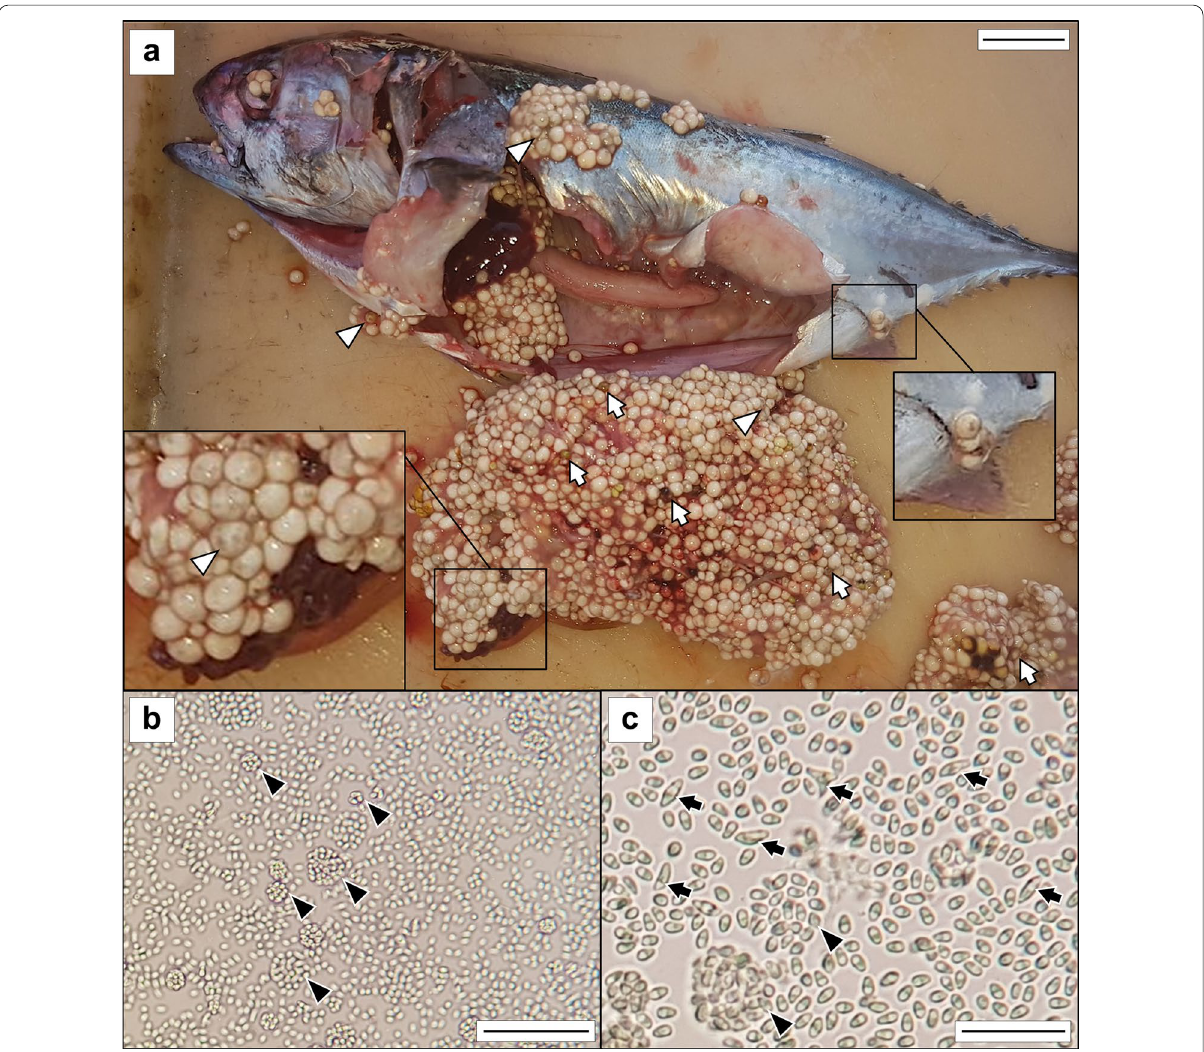
Fig. 1 Glugea thunni in Thunnus thynnus from the Mediterranean Sea. a Specimen of T. thynnus infected by G. thunni with melanized and partially melanized cysts, including a detail of xenomas within the ceacal mass (scale bar 2.5 cm) b fresh smear with free microspores and parasitophorous vesicles with different number of microspores (scale bar 40 µm). c Detail of fresh smear with free short and large microspores and parasitophorous vesicles (scale bar 20 µm). White arrow—melanized cyst; white arrowhead—cysts with melanized spots; black arrows—abnormal microspores; black arrowheads—parasitophorous